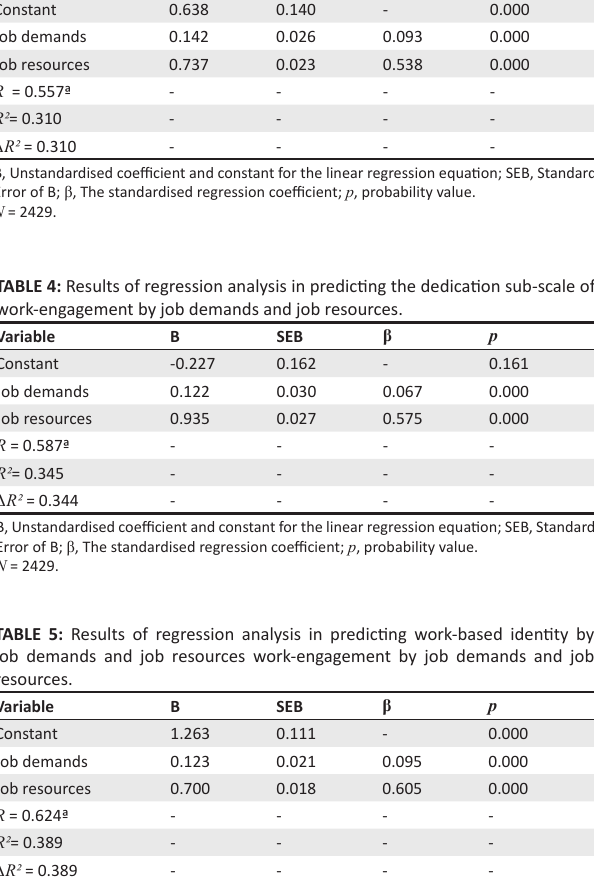
B, Unstandardised coefficient and constant for the linear regression equation; SEB, Standard Error of B; β , The standardised regression coefficient; p , probability value. N =